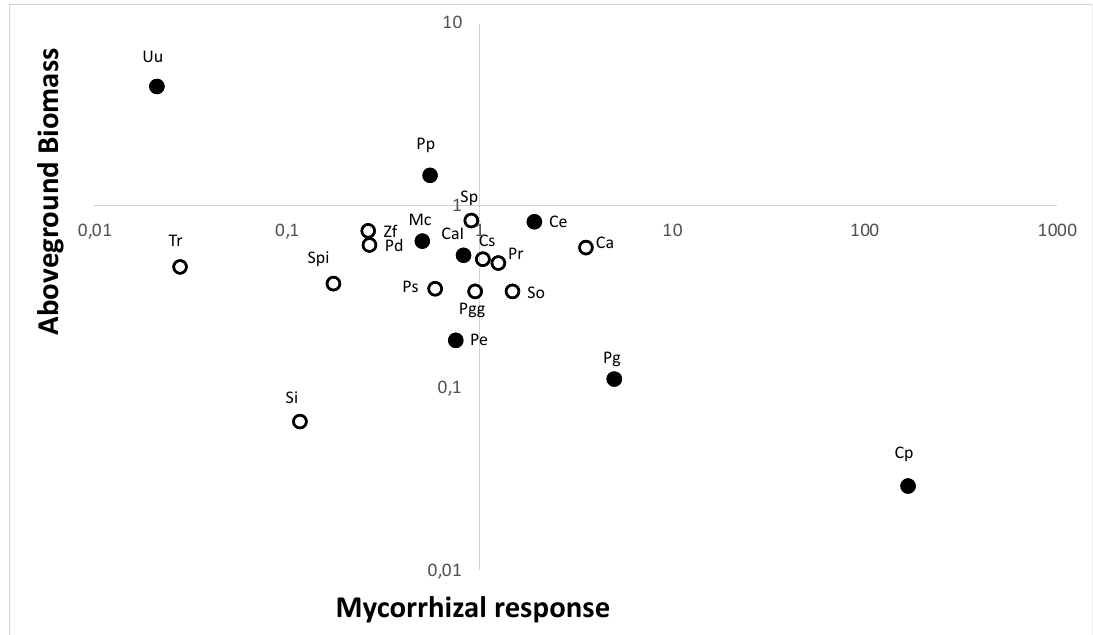
Figure 2. Scatterplot of log aboveground growth and log aboveground mycorrhizal response. Unfilled symbols represent native and filled symbols represent non-native plant species. Ca: Chiococa alba , CaI: Coffea arabica , Ce: Cestrum auriculatum , Cp: Cinchona pubescens , Cs: Croton scouleri var. grandifolius , Mc: